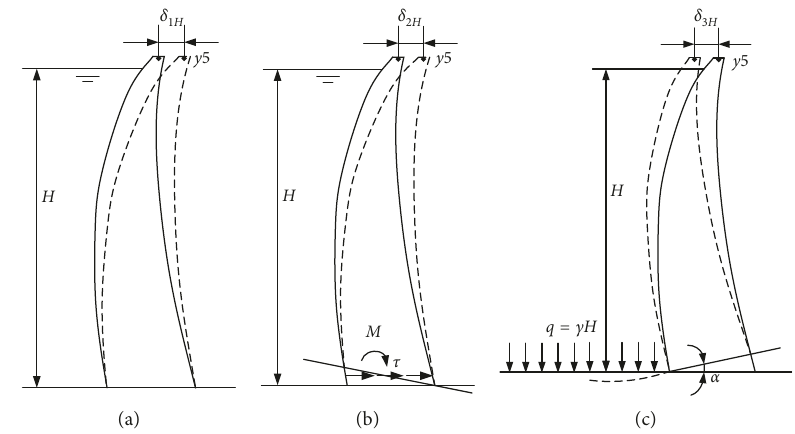
Figure 14: Three components (i.e., (a) δ